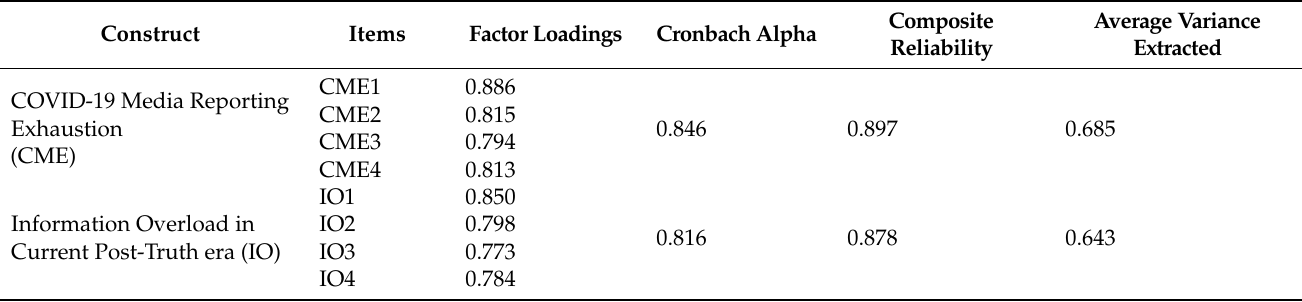
Table 2. Loadings and reliability testing of the